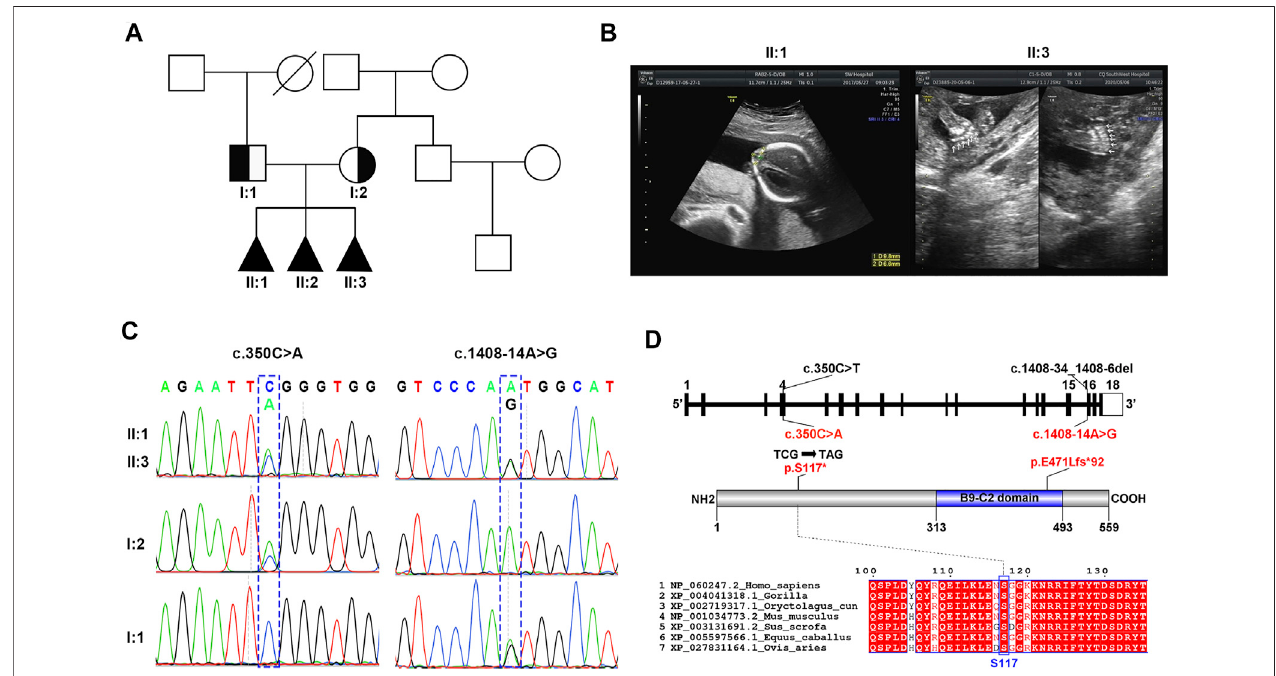
FIGURE 1 | Identi fi cation of novel MKS1 mutations in a Chinese family with MKS. (A) The pedigree of this family showed a history of abnormal pregnancy. (B) UltrasonographicimagesoffetusesII:1andII:3showedtheoccipitalencephaloceleandpostaxialpolydactyly,respectively. (C) Sangersequencingof MKS1